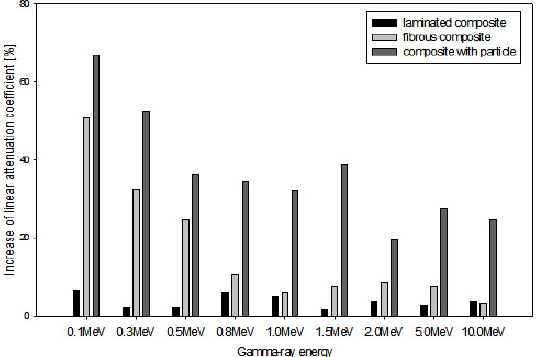
Figure 16. Rate of increase of linear attenuation coefficient caused by structural change of PE/tung- sten composite.